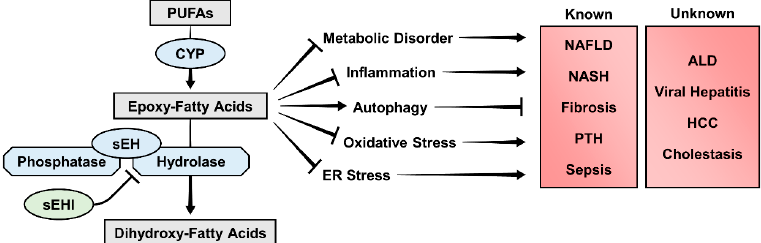
Figure 4. Summary figure. sEH inhibitors preserve levels of endogenously produced epFAs by preventing their sEH hydrolysis. sEH inhibition improves disease phenotype in non-alcoholic liver disease, non-alcoholic steatohepatitis, hepatic fibrosis, cirrhotic portal hypertension, and cirrhotic sepsis. Individual epFAs are shown to improve insulin resistance, inflammation, autophagy, oxidative stress, and endoplasmic reticulum stress, suggesting a mechanistic link between sEH inhibitors and protection against liver diseases. Future research should interrogate the efficacy of sEH inhibition in ALD, viral hepatitis, hepatocellular carcinoma, and cholestatic liver disease. PUFAs, polyunsaturated fatty acids; CYP, cytochrome P450 2J/2C families; sEH, soluble epoxide hydrolase; sEHI, soluble epoxide hydrolase inhibitor; NAFLD, non-alcoholic fatty liver disease; NASH, non- alcoholic steatohepatitis; PTH, portal hypertension; ALD, alcohol-associated liver disease; HCC, hepatocellular carcinoma.